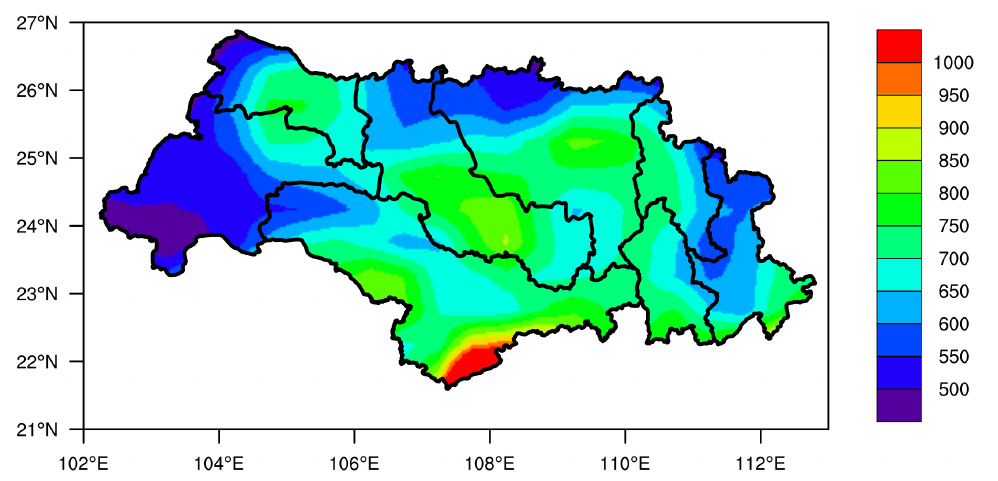
Figure 13. Mean precipitation from 1st June to 31st August for the 1980–2010